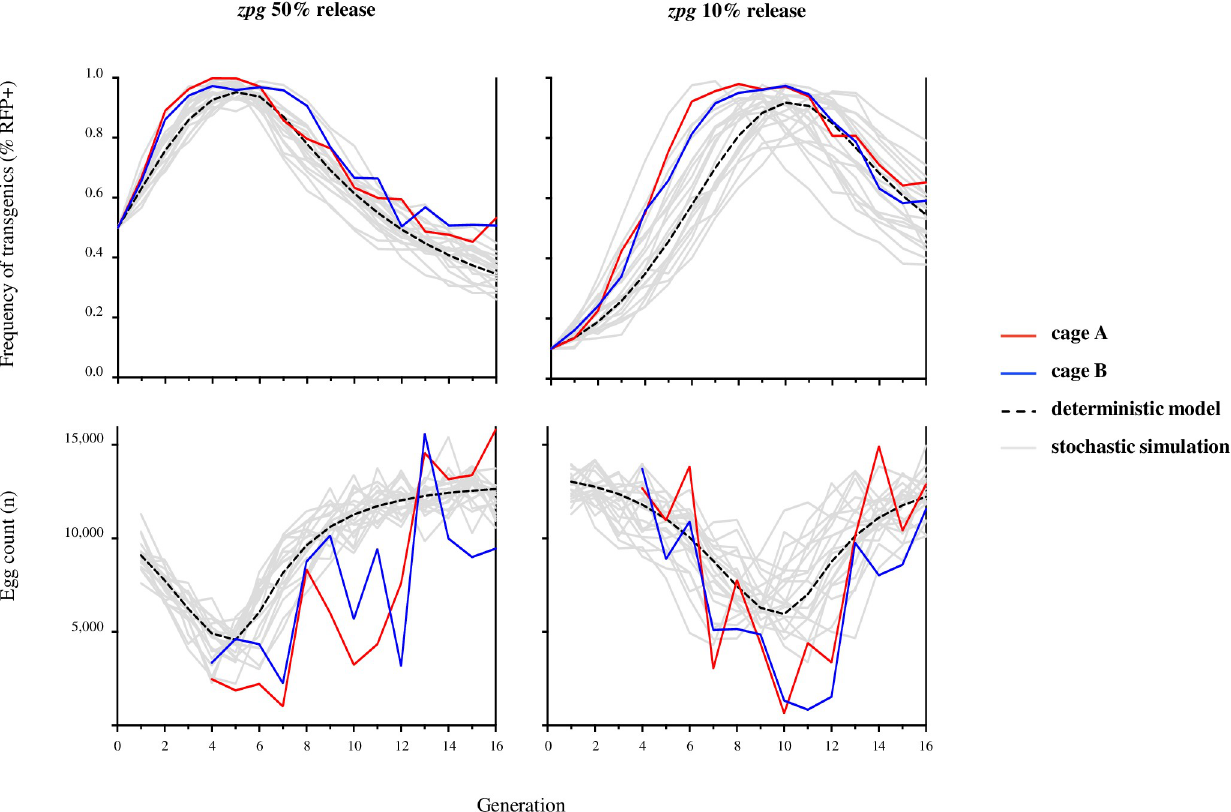
Fig 6. Comparison of observed zpg-CRISPR h drive frequency and egg output data to deterministic and stochastic model predictions. zpg-CRISPR h / + individuals were released into replicate caged WT populations at 50% (left) or 10% (right) initial frequency of CRISPR h / + . The frequency of drive-modified mosquitoes (top panels) and the entire egg output per generation (bottom panels) were recorded. Observed data were compared to a deterministic, discrete-generation model (dashed line) based upon observed rates of fertility, homing, and resistance generated by end-joining in the germline and embryo (S1 Table). Grey lines show 20 stochastic simulations assuming that females may fail to mate, or mate once with a male of a given genotype according to its frequency in the male population; mated females produce eggs in amounts determined by sampling with replacement from experimental values that subsequently hatch according to the genotype of the mother; of the 600 larvae chosen randomly to populate next generation, some fail to survive to adulthood. Probabilities of mating, egg production, hatching and survival from larval stage to adult are estimated from experiment (S2 Table) and random numbers for these events drawn from the appropriate multinomial distributions. Model egg counts for each release are normalised such that the deterministic value corresponds to the average of the two replicate cage experiments at generation sixteen.